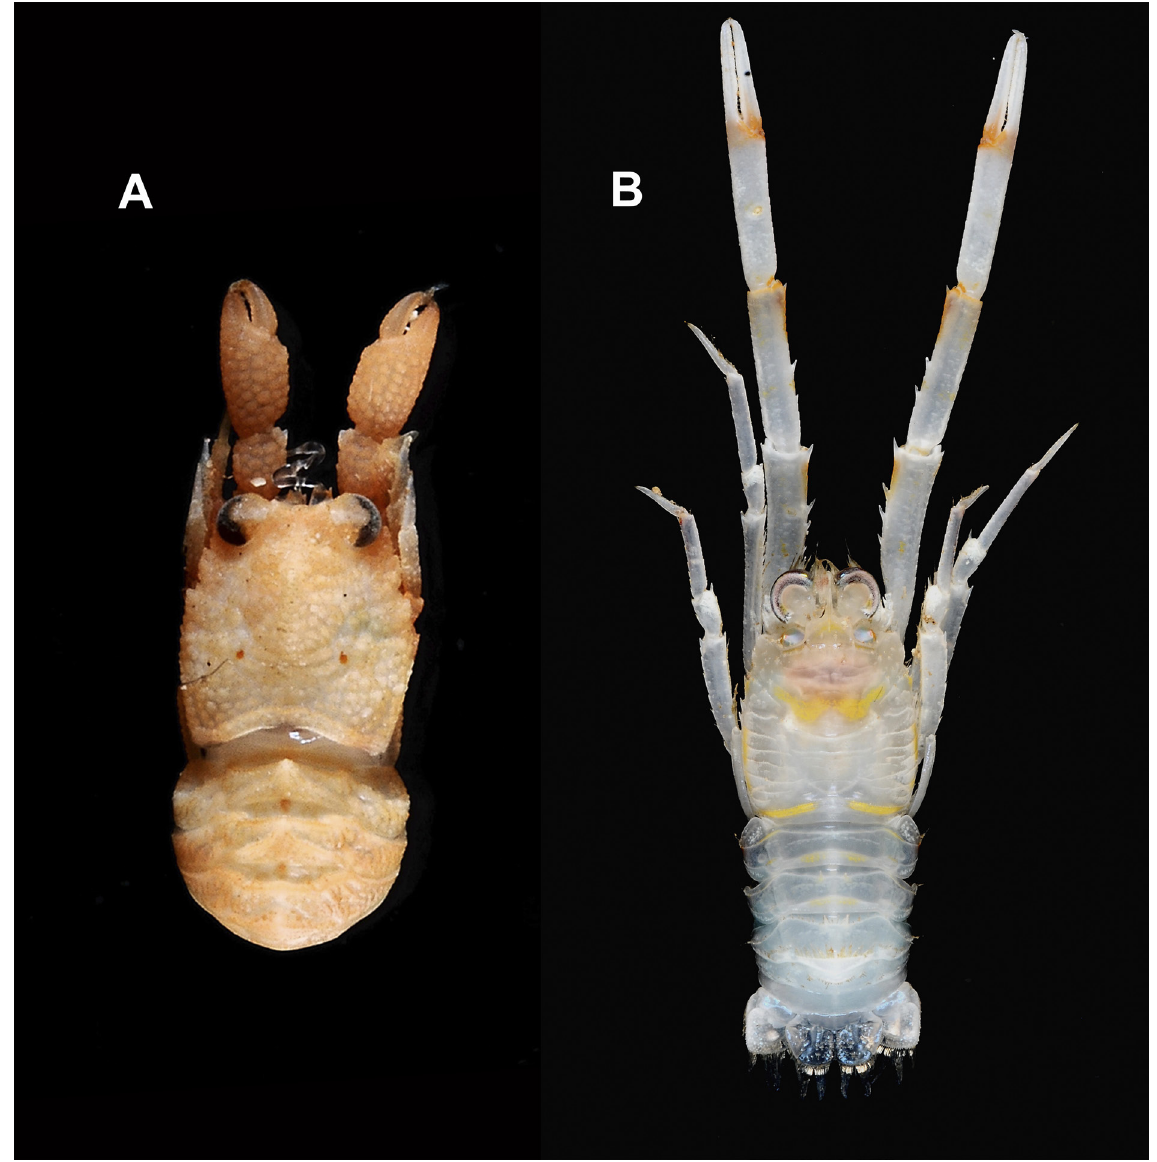
Fig. 6. Dorsal view. Colours in life. A . Heteronida ceres sp. nov., holotype, ♂, CL = 3.5 mm, New Caledonia, EXBODI, stn CP3927. B . Torbenella insolita (Macpherson, 2004), ov. ♀, CL = 7.2 mm, New Caledonia. EXBODI, stn